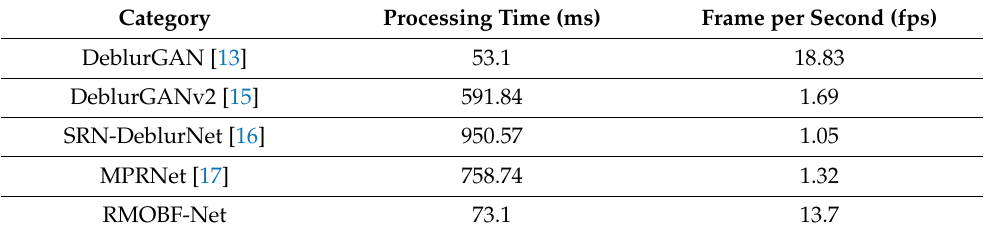
Table 11. Comparisons of processing time and speed as frame per second (fps) of the proposed method and the state-of-the-art restoration model on the Jetson TX2 embedded